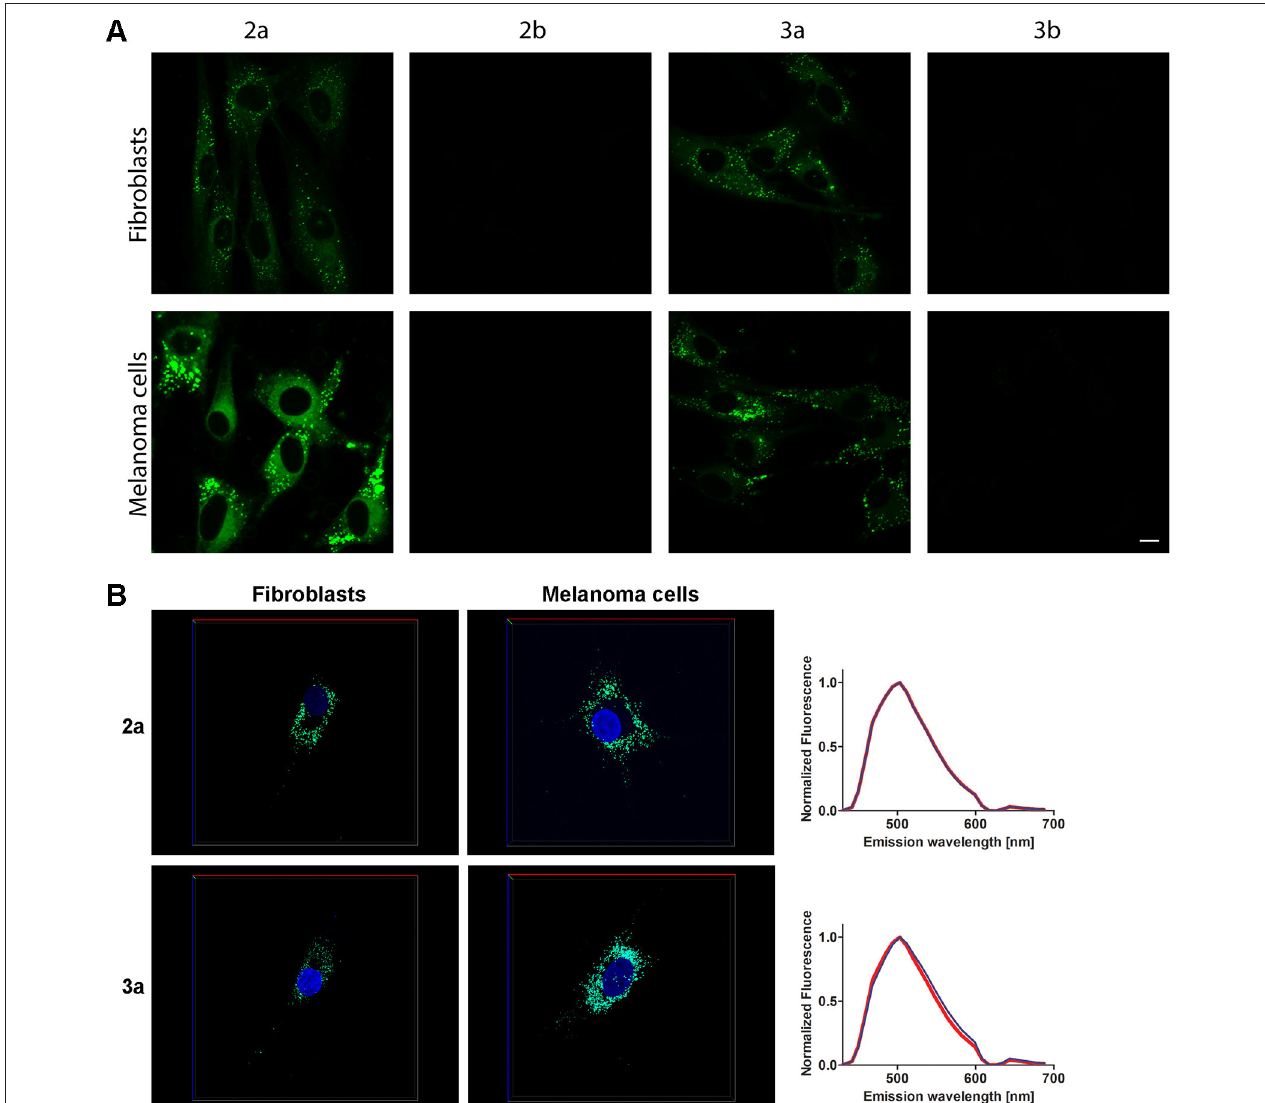
FIGURE 3 | Live staining of cells with the phosphole ligands. (A) Fluorescence images of human fibroblasts (AG01518) and malignant melanoma cells (SK-MEL-28) stained with phospholes 2–3a,b . Living cells were stained with probes (10 µ M, 24h) in complete cell culture medium and thereafter fixated. The cells were analyzed using an excitation wavelength at 405nm. Scale bar = 10 µ m. (B) 3D images of AG01518 (left) and SK-MEL-28 (middle) stained by DAPI (blue) and 2a or 3a . Images were collected in z-stack spectral mode (excitation at 405 and 458nm) with the dimensions x = 135 µ m (red line), y = 135 µ m (blue line) and z = 7.5 µ m (AG01518) or 13 µ m (SK-MEL-28) (green line). Emission spectra from 2a or 3a in the cytoplasmic compartments in AG01518 (blue) and SK-MEL-28 (red). Spectra were collected from five individual cytoplasmic compartments in 20 specific cells for each cell type and the spectra shown in (B) are the average of 100